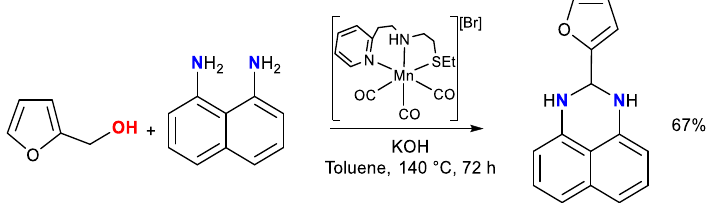
Table 2. Catalytic furfuryl alcohol amination with a primary amine as a nitrogen source. Entry Catalyst T (°C)